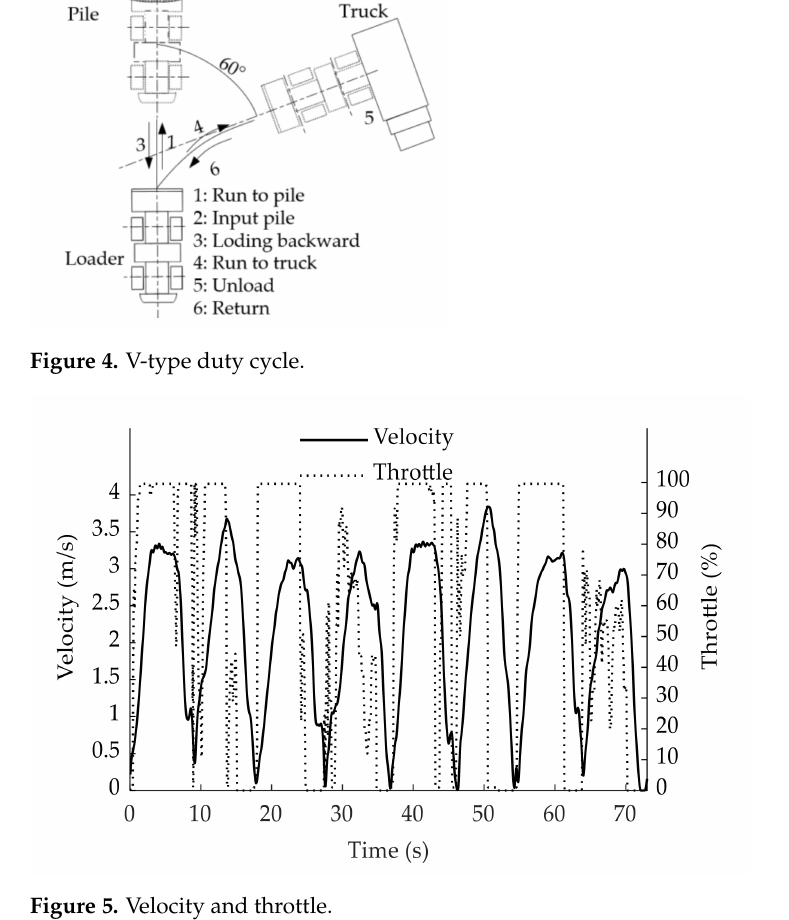
Figure 5. Velocity and